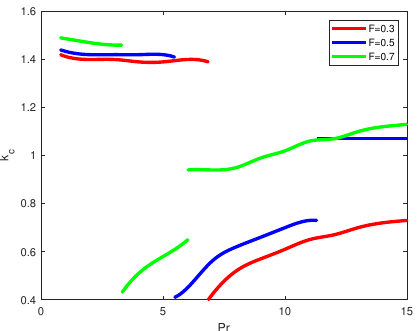
Figure 15. Critical wave numbers versus Pr for Case 1.